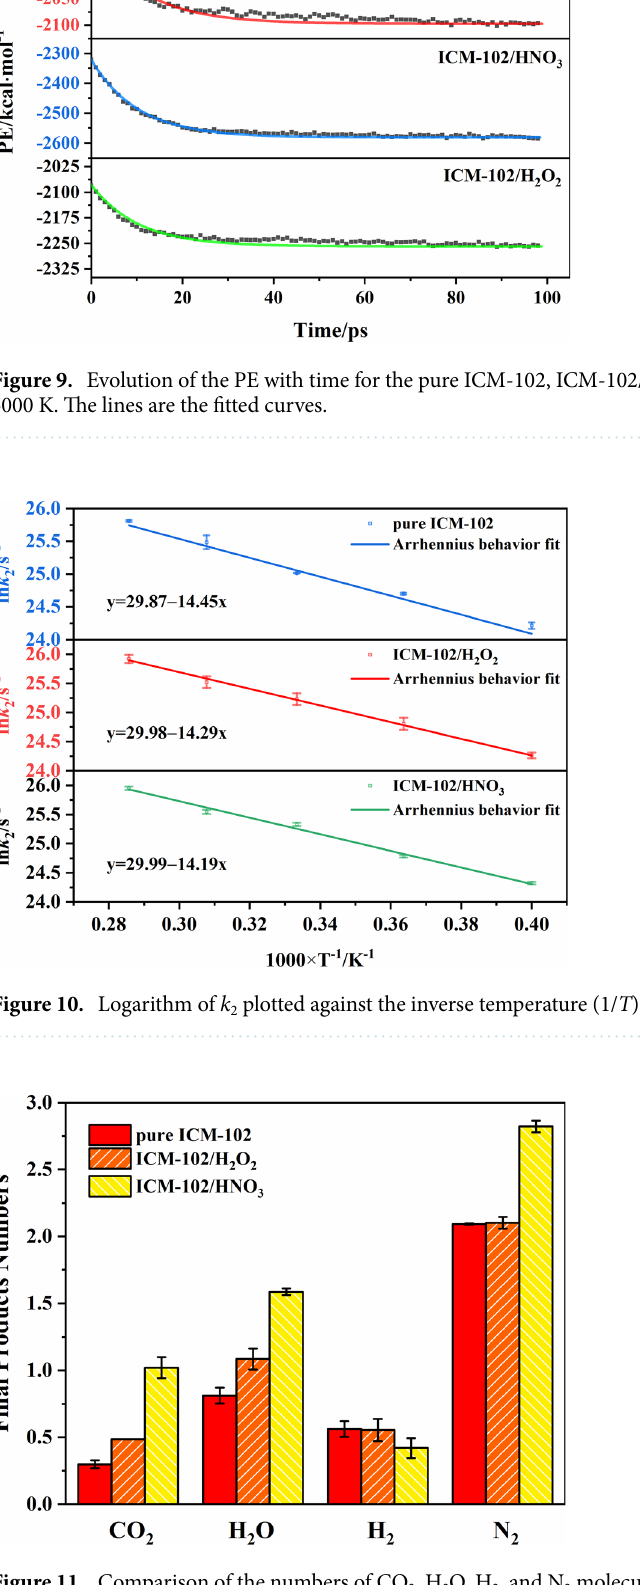
Figure 11. Comparison of the numbers of CO 2 , H 2 O, H 2 , and N 2 molecules in the pure ICM-102, ICM-102/ H 2 O 2 and ICM-102/HNO 3 systems at 3000